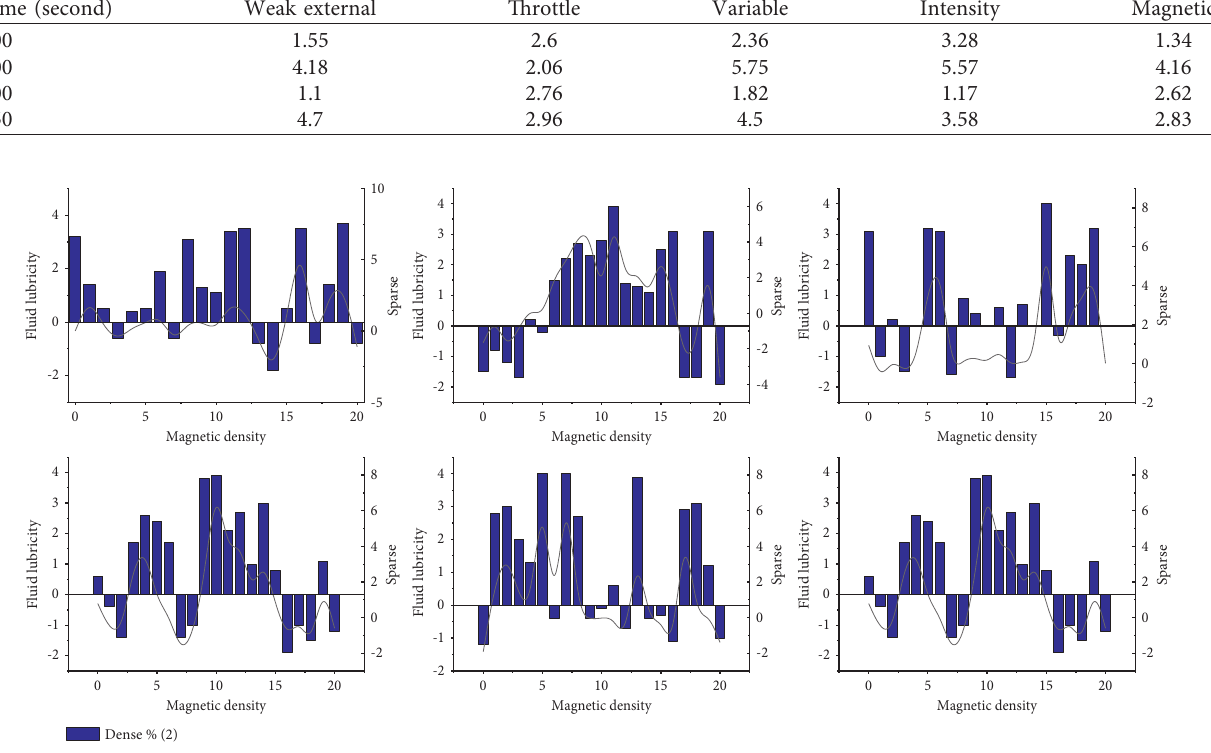
Figure 6: The relationship between ingredient ratio and